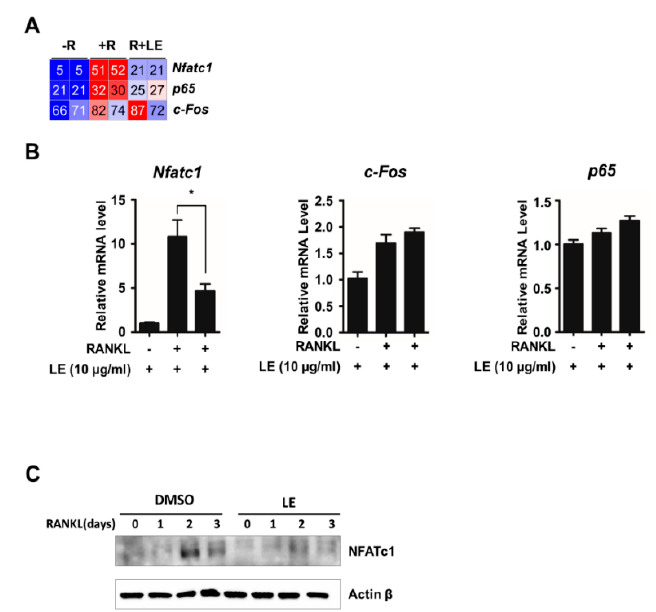
Figure 3. Leaf extract of Abeliophyllum distichum inhibits RANKL-induced NFATc1 expression. ( A ) Heatmap showing the reads per kilobase per million (RPKM) of c - Fos , p65 and Nfatc1 . Numbers within the figure indicate RPKM values. ( B ) BMM cells were cultured for 3 days in the presence of M-CSF (30 ng / mL) and RANKL (100 ng / mL) in the absence or the presence of LE. Total RNA was isolated from cell lysates, and qRT-PCR was performed using primers specific for c - Fos , p65 and Nfatc1. The mRNA levels were normalized against an internal β -actin control. The results shown are mean values from three independent experiments; * p < 0.05, ** p < 0.01, *** p < 0.001. ( C ) Whole cell lysates were prepared from M-CSF/RANKL-treated BMMs with or without LE (10 μ g/mL) for 0, 1, 2, and 3 days, and analyzed by immunoblotting with antibodies against NFATc1 or β -Actin.